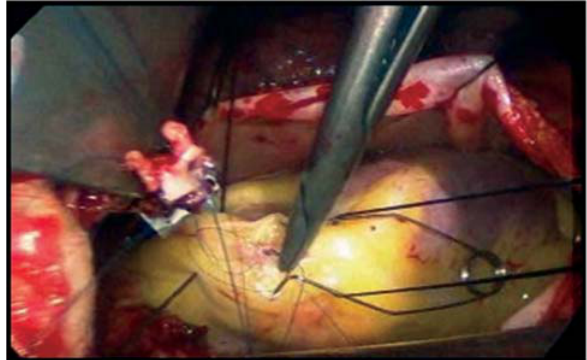
Fig. 4 - Anastomose da artéria torácica interna esquerda